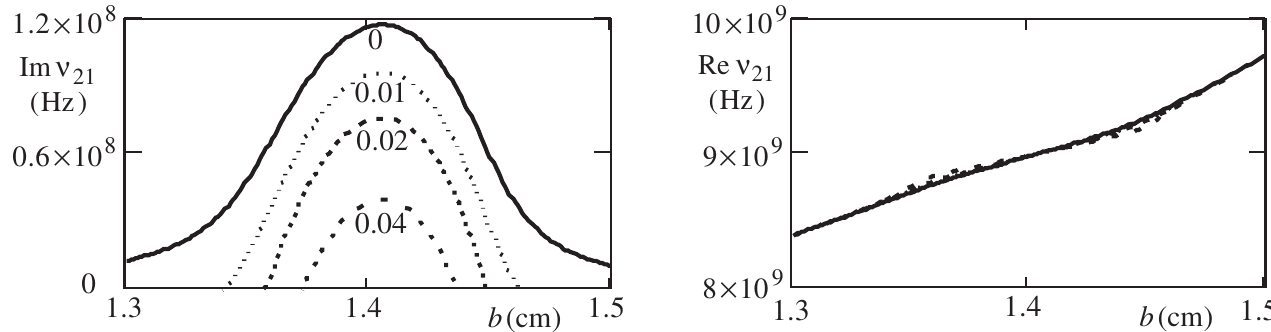
FIG. 3. Dependence of the imaginary and real parts of the mode frequency on the channel radius for a (cid:4) 2 cm . The corresponding values of Im " are